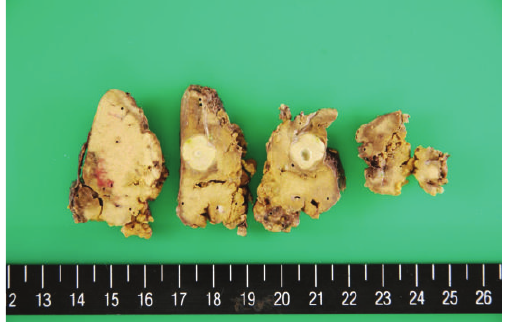
Figure 1: Computed tomography (CT) with contrast demonstrated a 11mm low-density lesion with mild ring enhancement on the rim in the arterial phase, located in the liver segment VI.